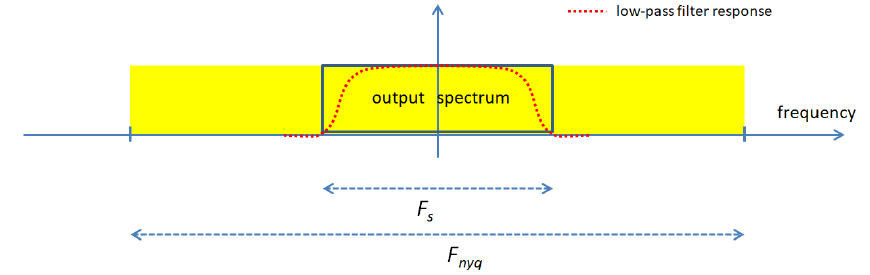
Figure 3. Illustration of the low-pass filter response and output